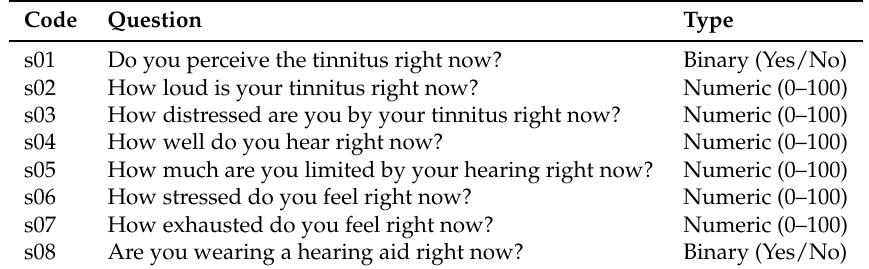
Table 1. EMA Questionnaire: Questions and scales for the answers to the EMA questionnaire.